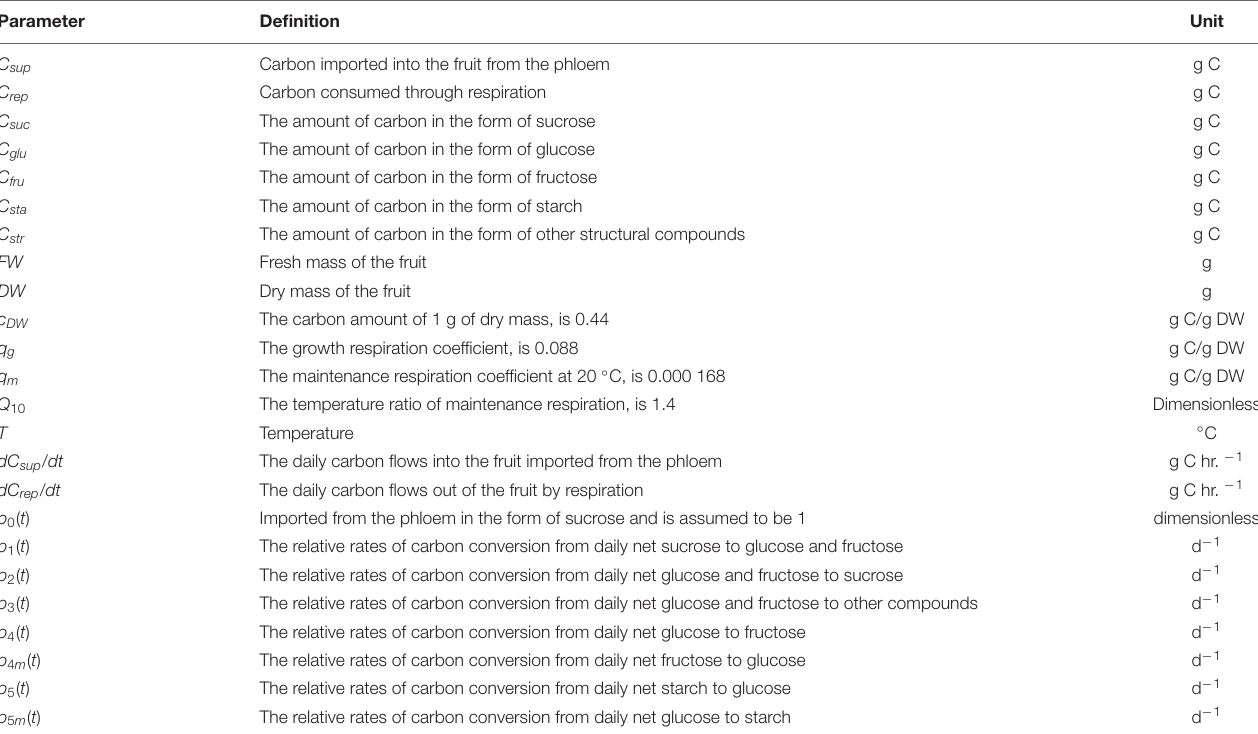
TABLE 2 | Definitions of carbon allocation and conversion parameters.